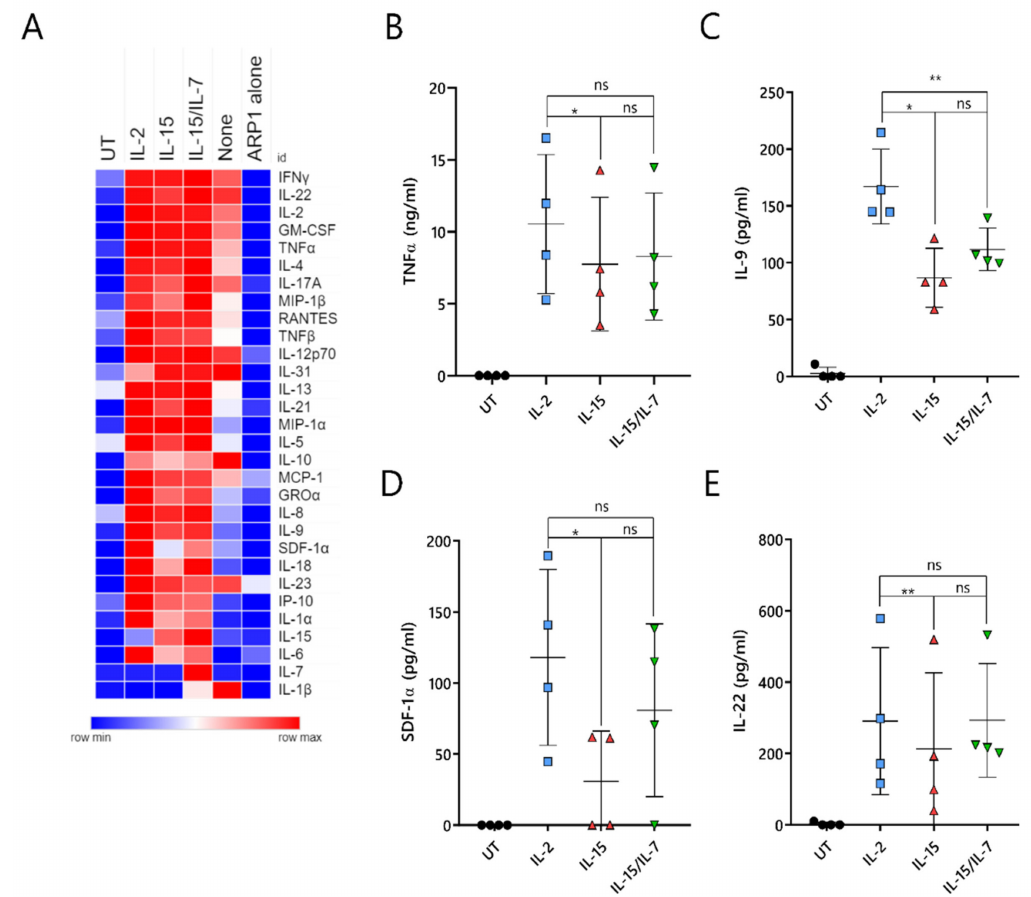
Figure 7. IL-15-grown ARI2h BCMA-CARs produce lower amounts of pathology-related cytokines. UT or ARI2h-transduced (ARI2h IL-2 , ARI2h IL-15 , ARI2h IL-15/IL-7 , ARI2h None ) T cells, or media (“ARP1 alone”), were co-cultured with ARP-1 cells for 6 h. ( A ) Heat map showing the relative secretion of a panel of cytokines and chemokines (shown on the right-hand side) as analyzed using a ProcartaPlex Multiplex Immunoassay kit ( n = 4, UT, IL-2, IL-15 and IL-15/IL-7 groups; n = 2, “None” group). The relative abundance of each molecule in the analyzed supernatant is shown on a scale of blue (low) to red (high). ( B – E ) Individual quantification of TNF α ( B ), IL-9 ( C ), SDF-1 α ( D ) and IL-22 ( E ) levels from panel A. * p < 0.05; ** p < 0.01; ns, not